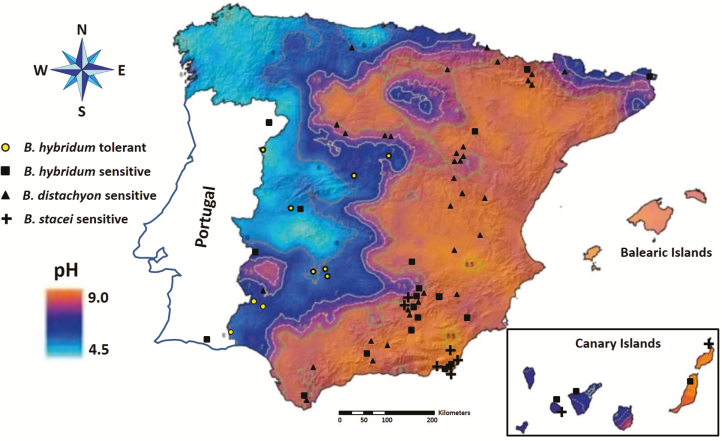
Map of Spain and Portugal including the soil pH data from Fernández et al. (1971), Rita and Rossello (1989) and López and Grau (2004). The location of the different Brachypodium distachyon and B. stacei diploid accessions and B. hybridum allotetraploid accessions is indicated.